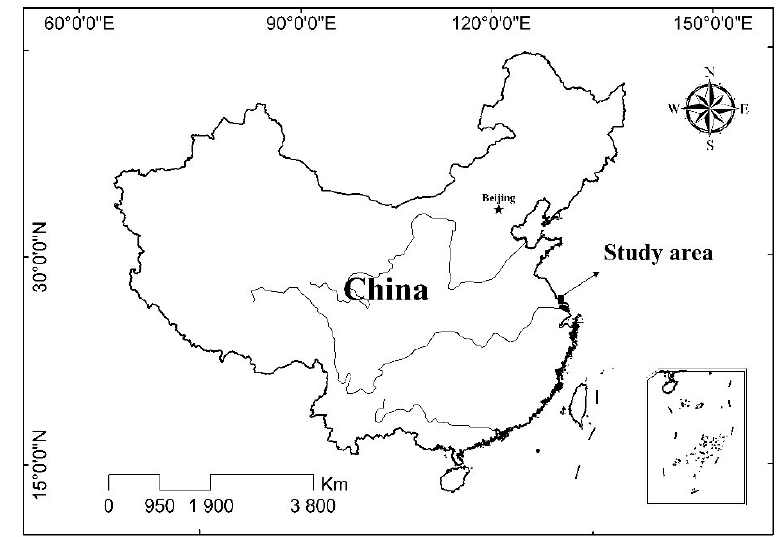
Figure 1. The location of the study area.